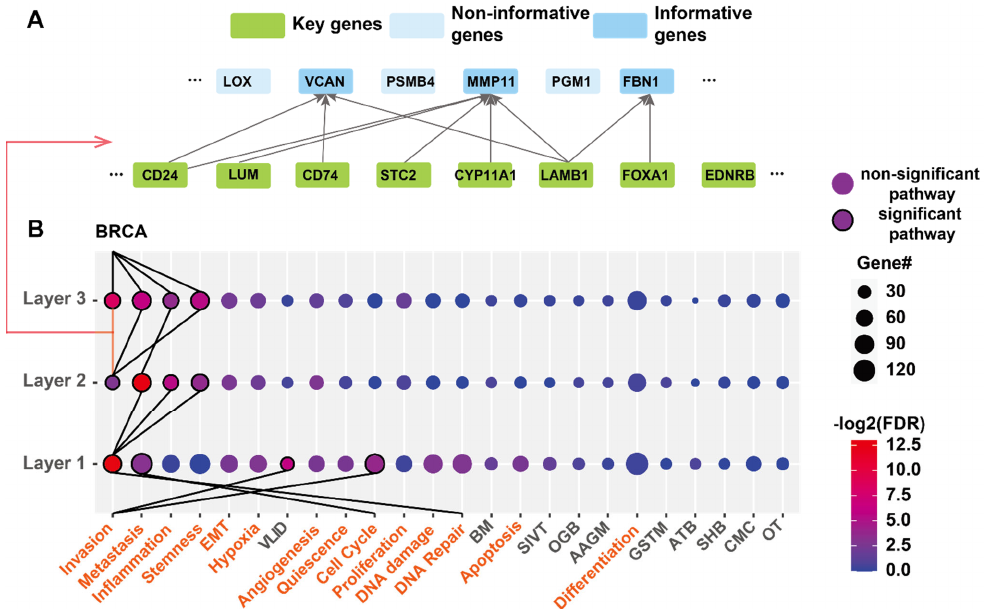
Figure 3. Functions of T ‐ GEM each layer for cancer type classification. A. snapshot of layer 3 after thresholding the weight attribution scores. The links are associated with scores larger than the threshold. Query genes with no links are non ‐ informative genes. ( B ) Enriched functions of each layer for the classification of breast cancer (BRCA). ( A ) link connects an enriched pathway with a pathway in the previous layer if this pathway’s informative gene ‐ associated Key genes are enriched the pathway at the previous layer. The size of the dots represents the number of enriched informative genes in each pathway genesets, and the color shows the enrichment significance (FDR). FDR is negative log2 transferred, red means more significantly enriched, and blue means less enriched. The genesets from cancer states are marked as orange, and genesets from KEGG pathway are black. The pathway is ranked based on the sum of − log2(FDR) for all 3 layers. Abbr. VLID (VALINE_LEUCINE_AND_ISOLEUCINE_DEGRADATION); BM (BUTANOATE_METABOLISM); SIVT(SNARE_INTERACTIONS_IN_VESICULAR_TRANSPORT); OGB (O_GLYCAN_BIOSYNTHESIS); AAGM(ALANINE_ASPARTATE_AND_GLUTAMATE_METABOLISM); GSTM (GLYCINE_SERINE _AND_THREONINE_METABOLISM); ATB(AMINOACYL_TRNA_BIOSYNTHESIS) SHB (STEROID _HORMONE_BIOSYNTHESIS); CMC(CARDIAC_MUSCLE_CONTRACTION); OT(OLFACTORY